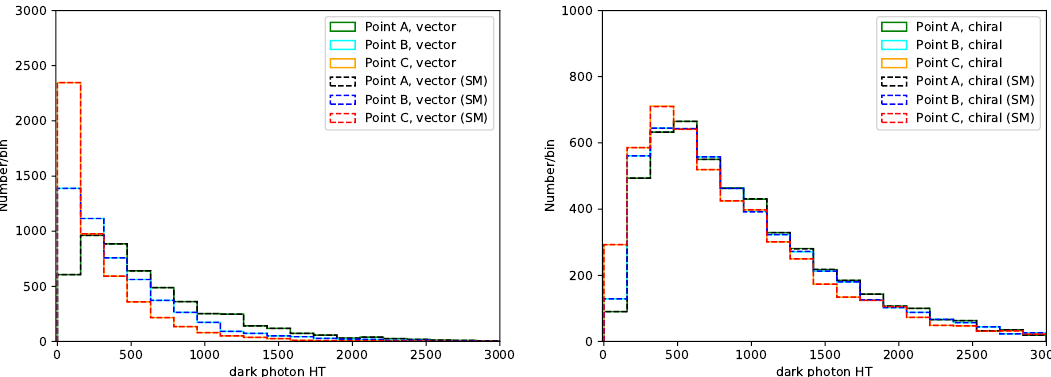
Figure 5 . Comparison between H T with the dark photons as (cid:12)nal states and that with the SM particles which the dark photons decay to as (cid:12)nal